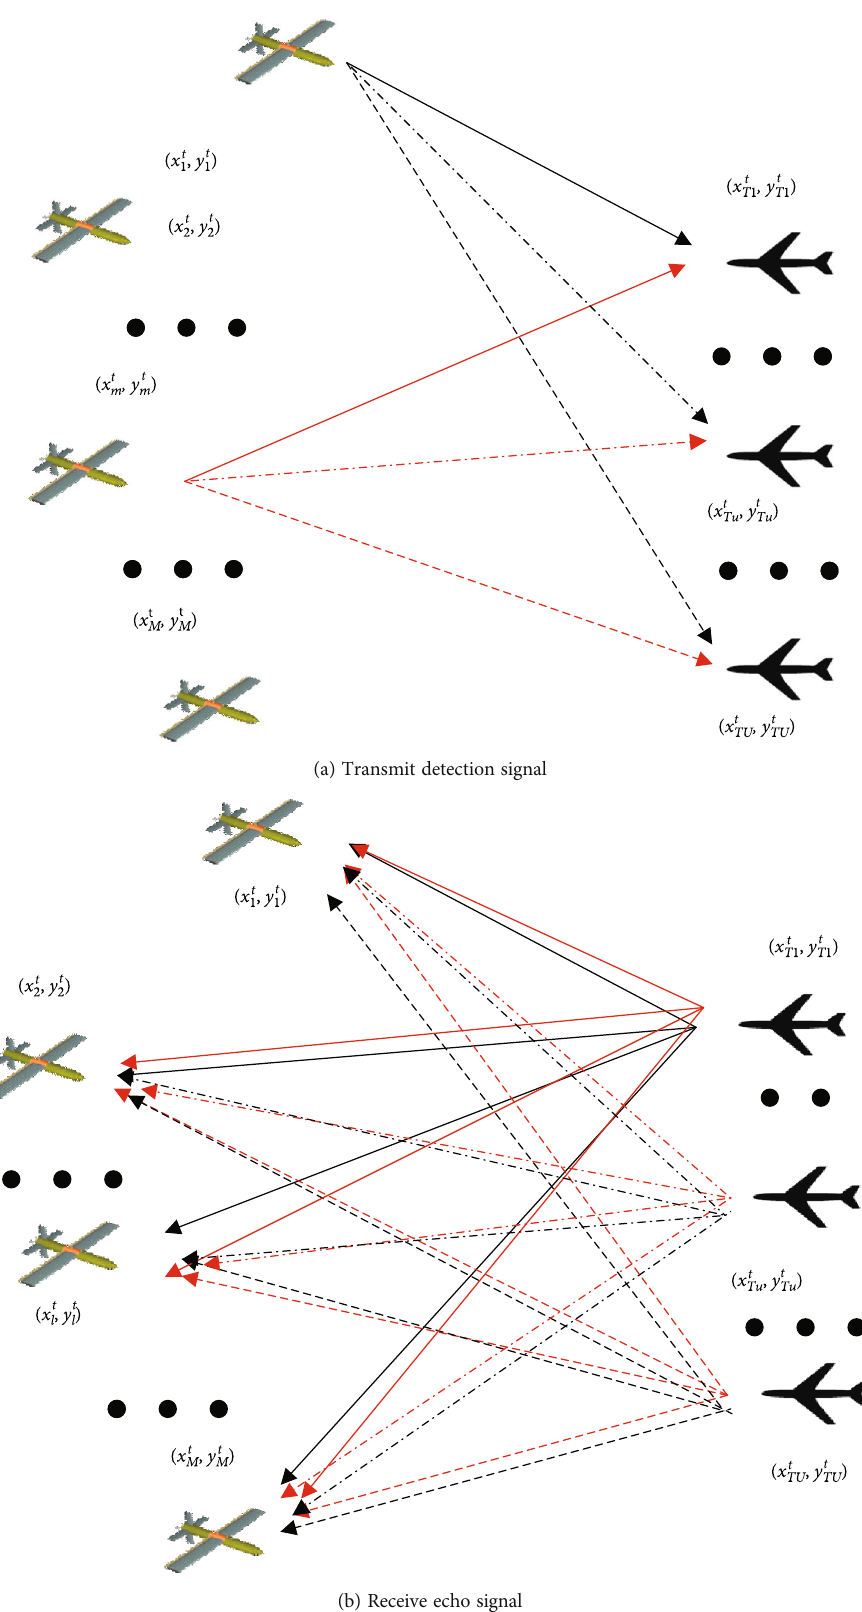
Figure 1: Schematic diagram of MIMO